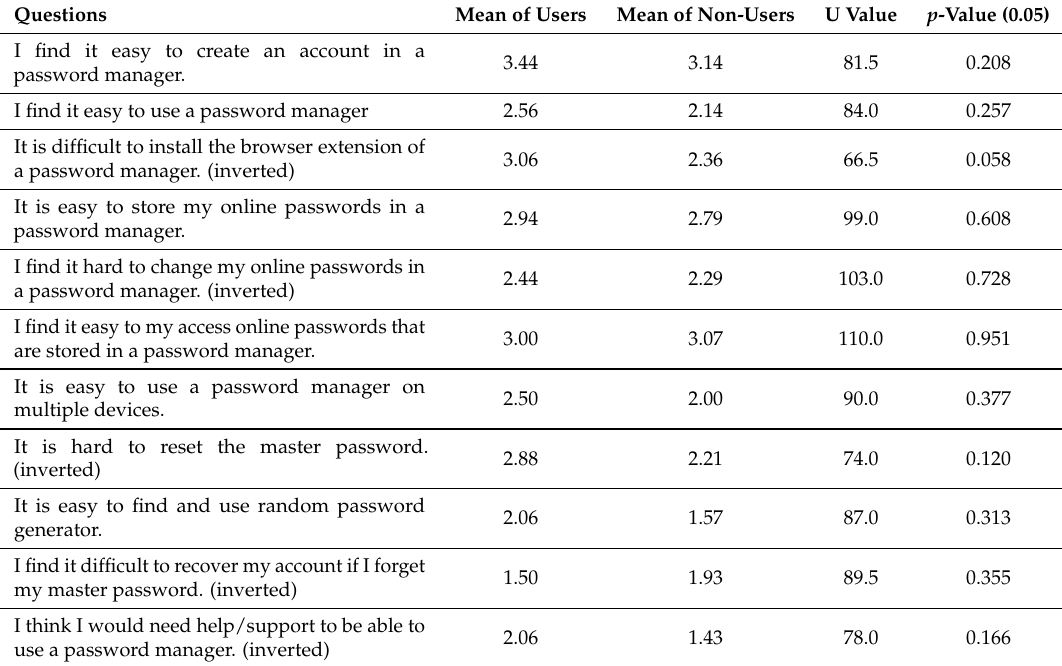
Table 8. The mean, Mann Whitney U value and p -value of each question for 16 users and 14 non-users (easy to use). Exact significance is displayed for this test [2*(1-tailed sig.)].